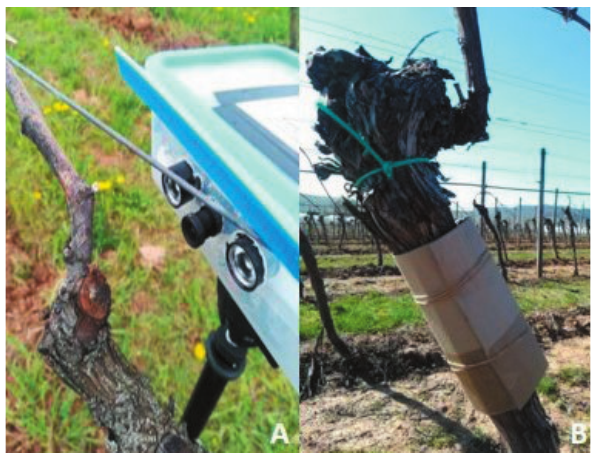
Figure 1. Camera focused on pruning wounds (A), and cardboard trap mounted around a grapevine trunk (B), used to monitor insects on